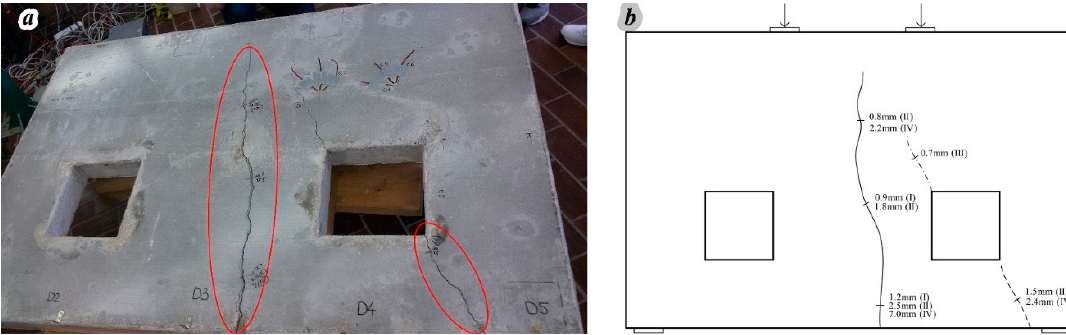
Figure 20. Crack and failure pattern: ( a ) tested member W2 at maximum load, ( b ) schematic view.